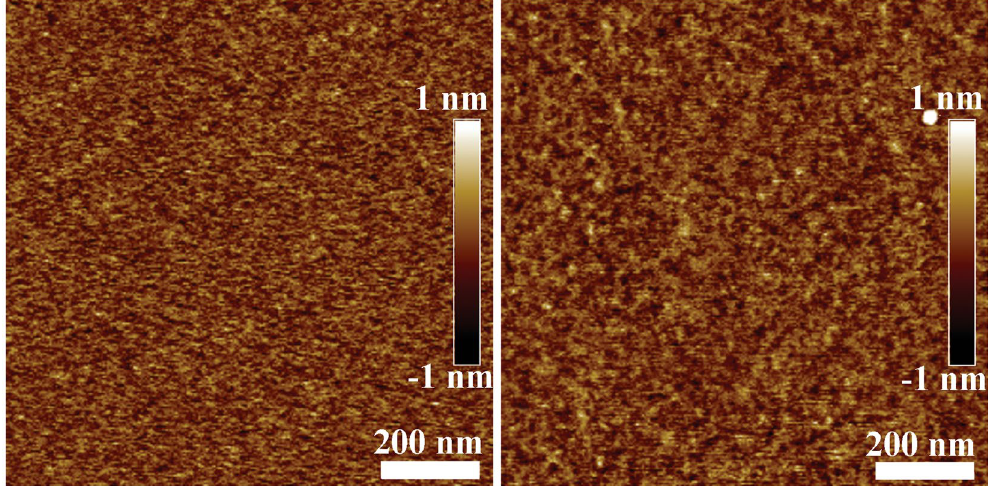
Figure 1. AFM topography of different thick BFO layers on As doped silicon wafer. ( a ) 2 nm; ( b ) 3.5 nm.